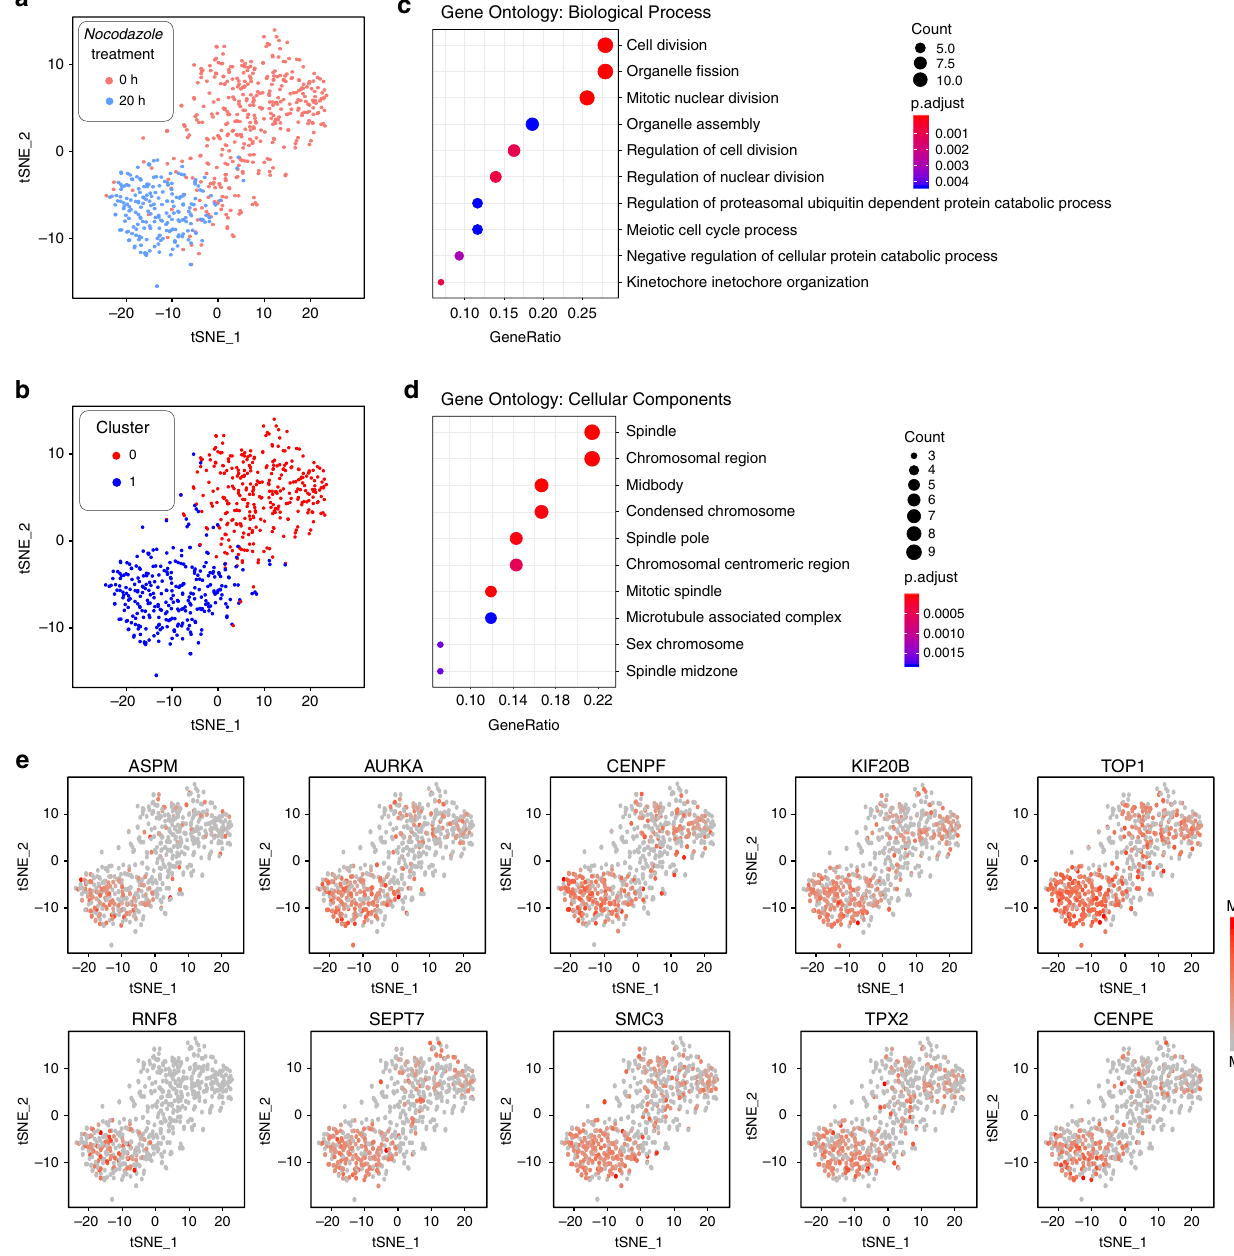
Fig. 6 Heterogeneity of Nocodazole treated cancer cells. a t-SNE visualization of K562 cells (RNA-seq) colored by Nocodazole treatment time or b unsupervised clustering ID. c Biological process and d cellular components analysis of gene ontology enrichment for the top 50 genes that are elevated in the treated cluster. e t-SNE maps of Nocodazole treated and untreated K562 cells. Gene expression levels are indicated by shades of red. All the genes shown in the map are correlated to the activated mitosis. Source data are provided as a Source Data fi single-cell expression pro fi le of mES cells and anti-cancer drug treated cells, we veri fi ed the reproducibility and signi fi cant detection ability for varying genetic expression, presenting great potential for cell biology, developmental biology and precision medicine.